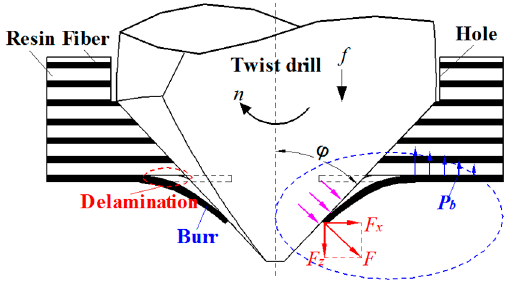
Figure 1. Damages production model in drilling AFRP.